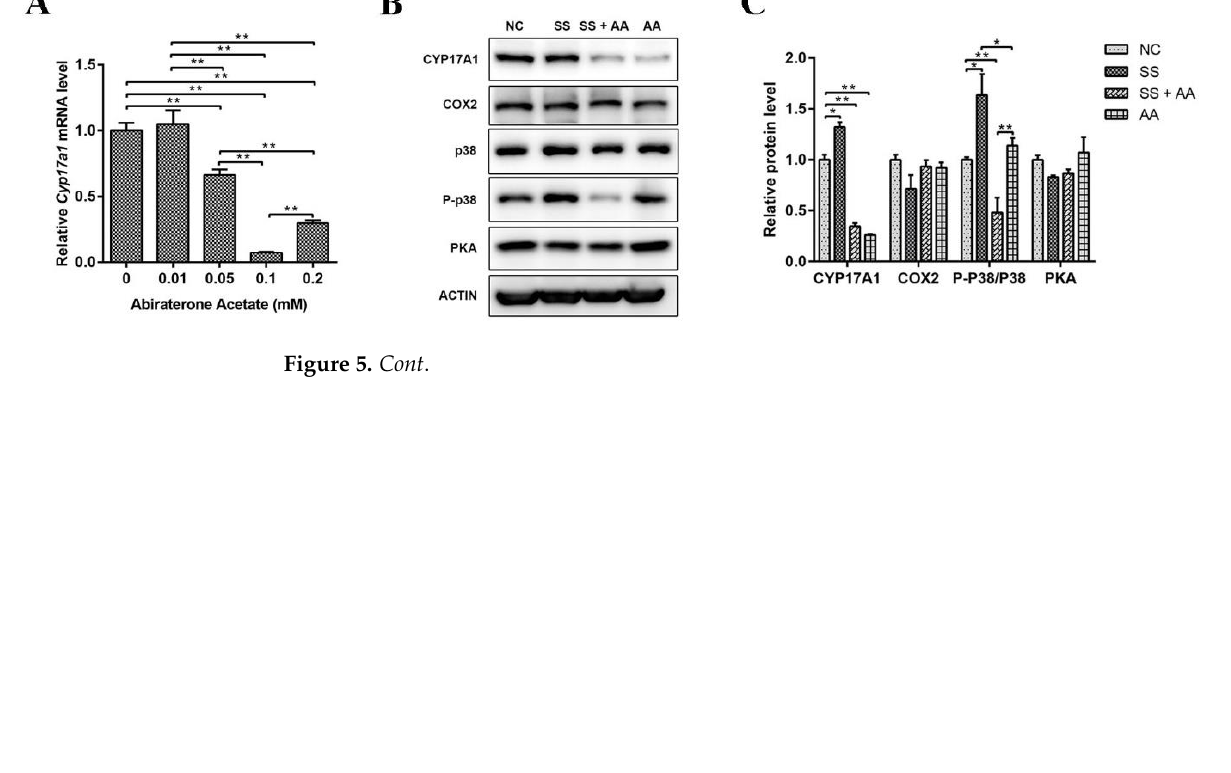
232 Figure 5. Effects of CYP17A1 inhibition on sodium salicylate. ( A ) Inhibitory effects on ovarian 233 Cyp17a1 mRNA levels after the intraperitoneal injection of abiraterone acetate (AA). ( B, C ) Impact 234 of abiraterone acetate on CYP17A1, COX2, P-p38, and PKA protein levels in the ovary. ( D ) Abi- 235 raterone acetate inhibited the superovulation effect of sodium salicylate (SS; n = 6). ( E ) Abiraterone